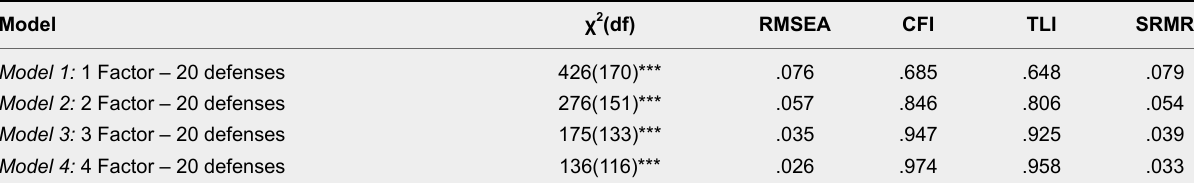
Summary of Goodness of Fit Statistics for EFA Contrasting Alternative Models of DSQ-40 Model χ 2